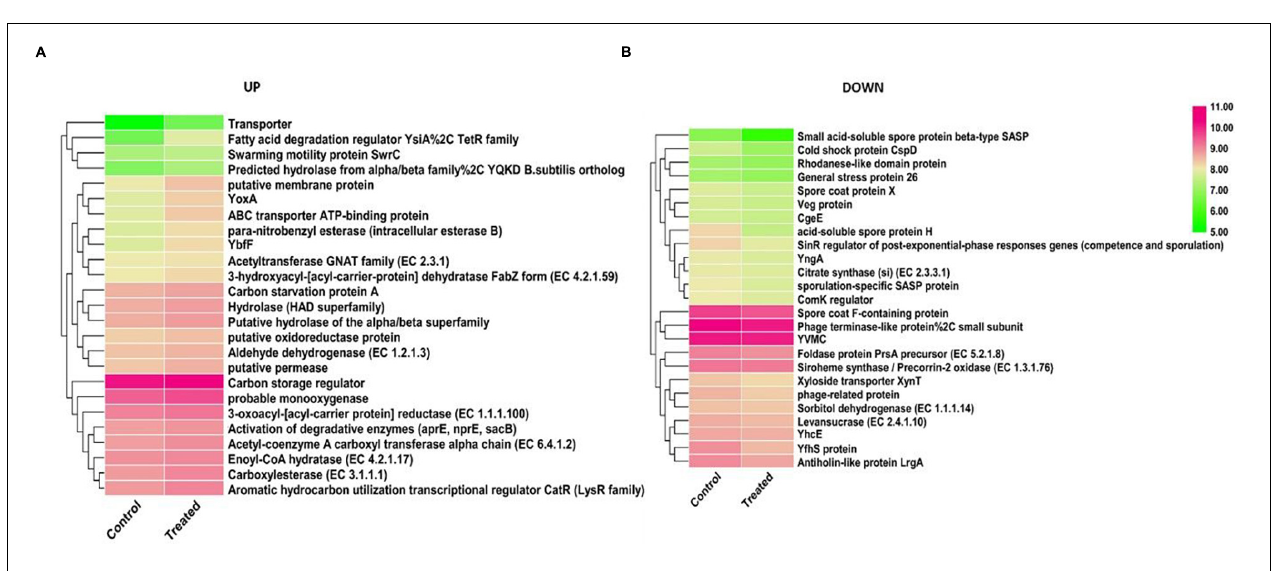
FIGURE 5 | Bond indexes of PET film after incubation (A) without and (B) with Bacillus species AIIW2 for 3 months. KCBI, Keto Carbonyl Bond Index; ECBI, Ester Carbonyl Bond Index; VBI, Vinyl Bond Index; IDBI, Internal Double Bond Index.